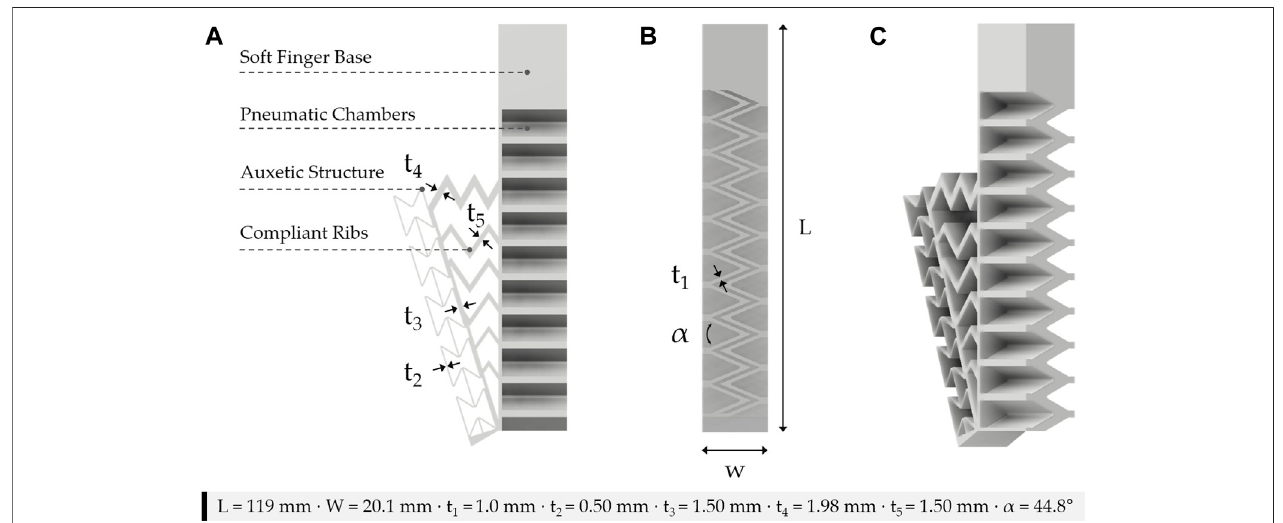
FIGURE 2 | 3D printed soft monolithic fi nger with mechanical metamaterial (A) three-dimensional view, (B) top view, and (C) side view.